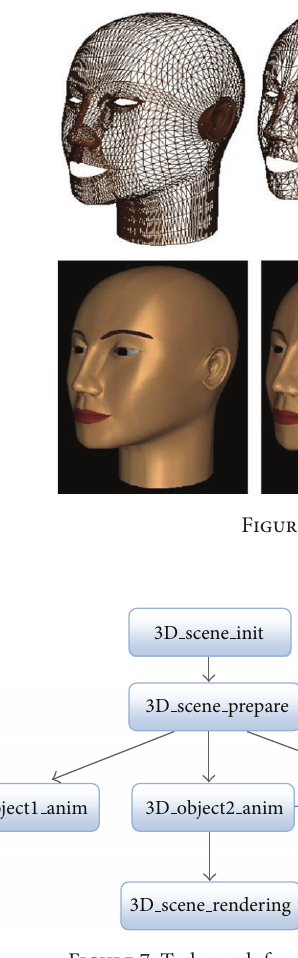
Figure 7: Task graph for a 3D